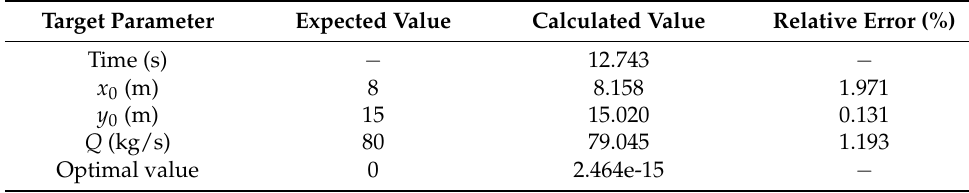
Table 8. Qualitative results table of OMO algorithm under 16 sensors.